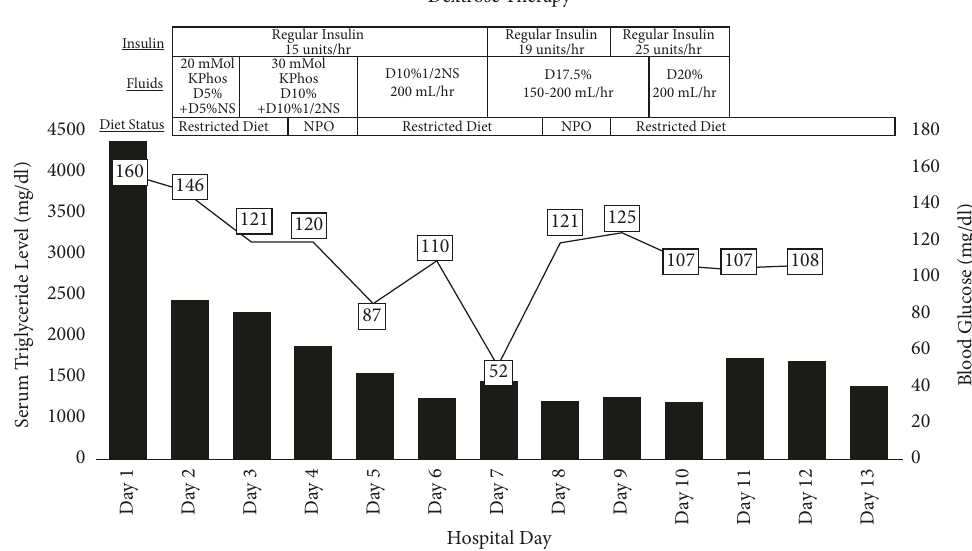
Figure 2: Serum triglycerides and blood glucose during hospital